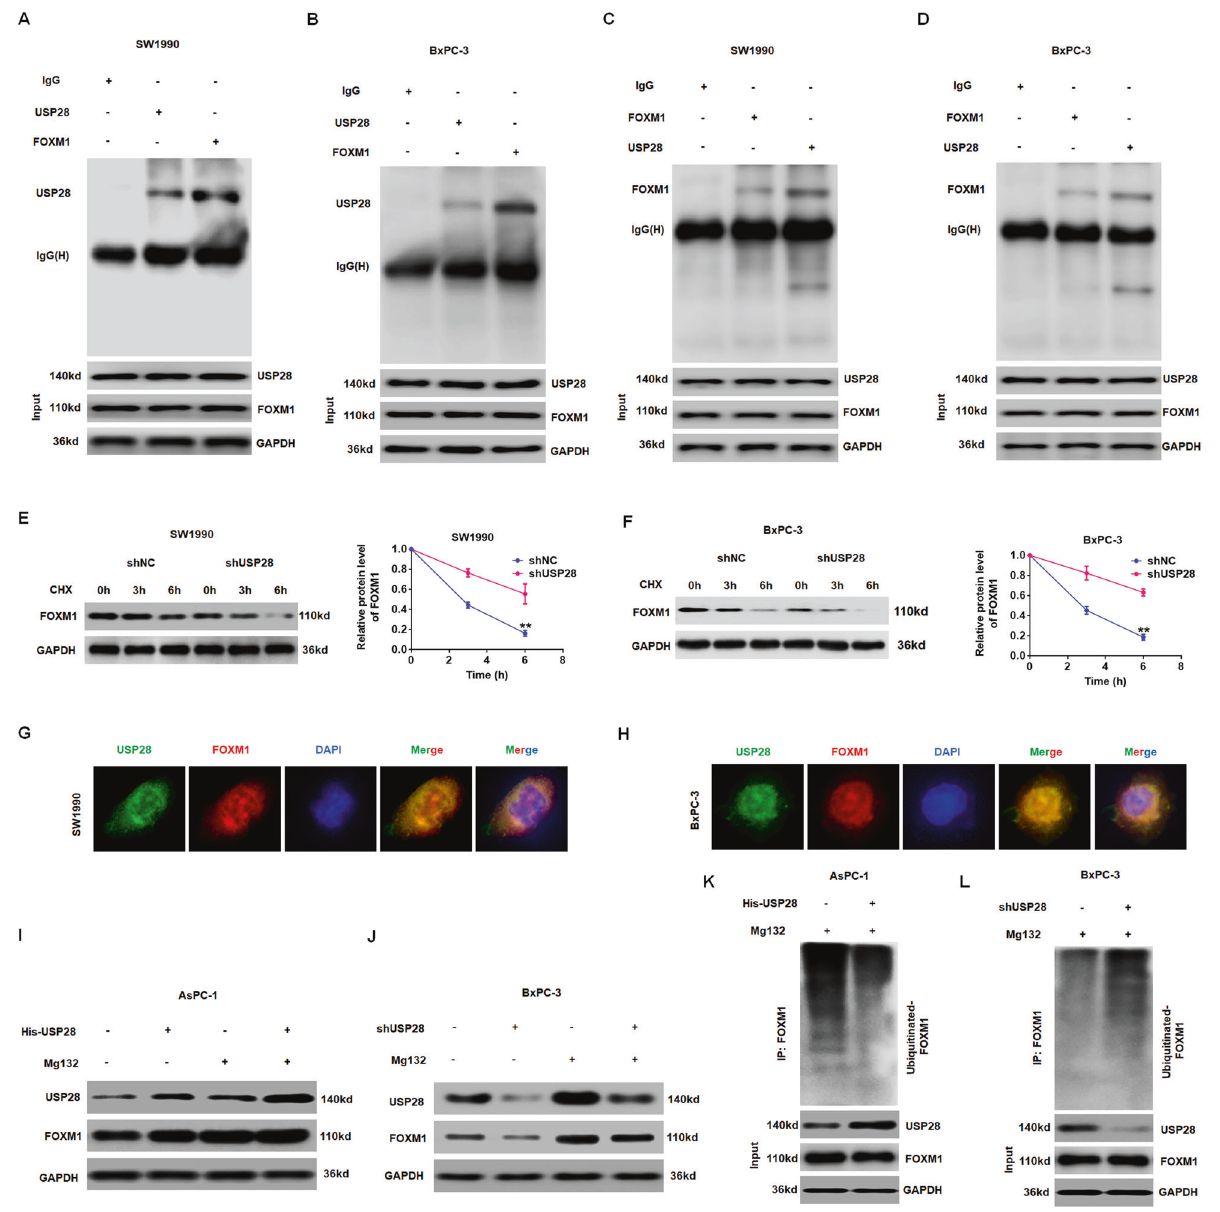
Fig. 6 USP28 interacting with FOXM1 and stabilising FOXM1 expression via deubiquitination. A – D The interaction between USP28 and FOXM1 was con fi rmed by co-immunoprecipitation (IP) in SW1990 cells and BxPC-3 cells. E , F Co-localisation studies of PC cells using anti- USP28 antibody (1:100, green) and anti-FOXM1 antibody (1:100, red), followed by DAPI nuclear counterstaining (blue). The merged images of USP28 (green) and FOXM1 (red) with DAPI (blue) are also shown. Scale bar, 50 μ m. G , H Representative (right) and quantitative (left) results of FOXM1 protein level in USP28-silencing cells. The cells were treated with cycloheximide (CHX, 100 mg/ml) for indicated time points were subjected to western blot analysis. ** P < 0.01. I J PC cells transduced with p-USP28 ( I ) or shUSP28 ( J ) were treated with 10 μ M MG132. Cells were collected at 6 h and immunoblotted with the antibodies indicated. K , L Lysates from PC cells transduced with p-USP28 ( K ) or shUSP28 ( L ) were immunoprecipitated with the anti-Ub and immunoblotted with the anti-FOXM1. Cells were treated with MG132 for 6 h before we assessed the degeneration of FOXM1 protein in USP28- knockdown cells after cycloheximide exposure. As shown in Fig. 6G, H, the data indicate that USP28-silencing signi fi cantly promoted the degeneration of FOXM1 protein in PC cells. Thirdly, we found that the protein level of FOXM1 was restored in USP28- overexpression or USP28 knockdown PC cells following treatment with proteasome inhibitor MG132 (Fig. 6I, J). Finally, ectopic